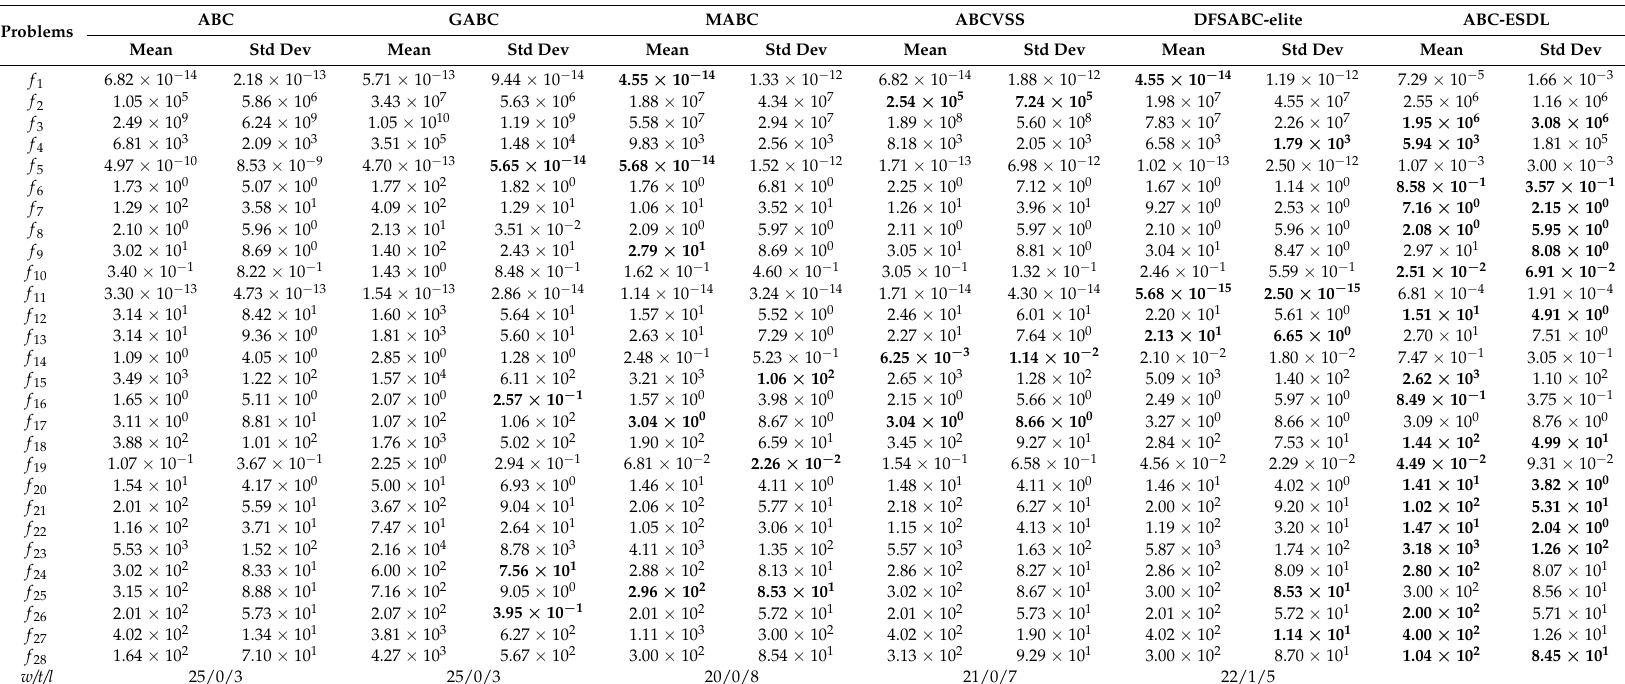
Table 7. Results on the CEC 2013 benchmark